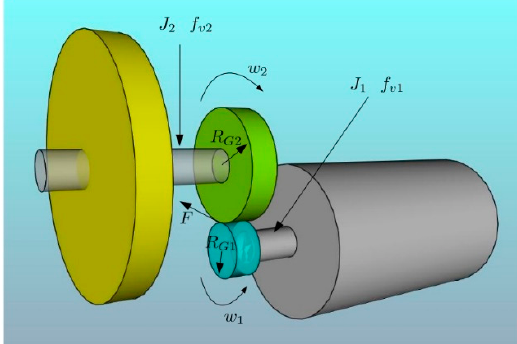
Figure 2. Parameters and variables of the system.